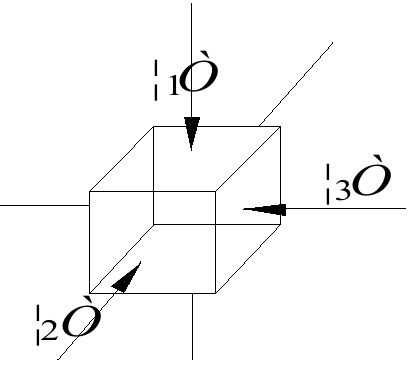
Figure 2. Schematic diagram of the principal stress distribution at a certain point in coal